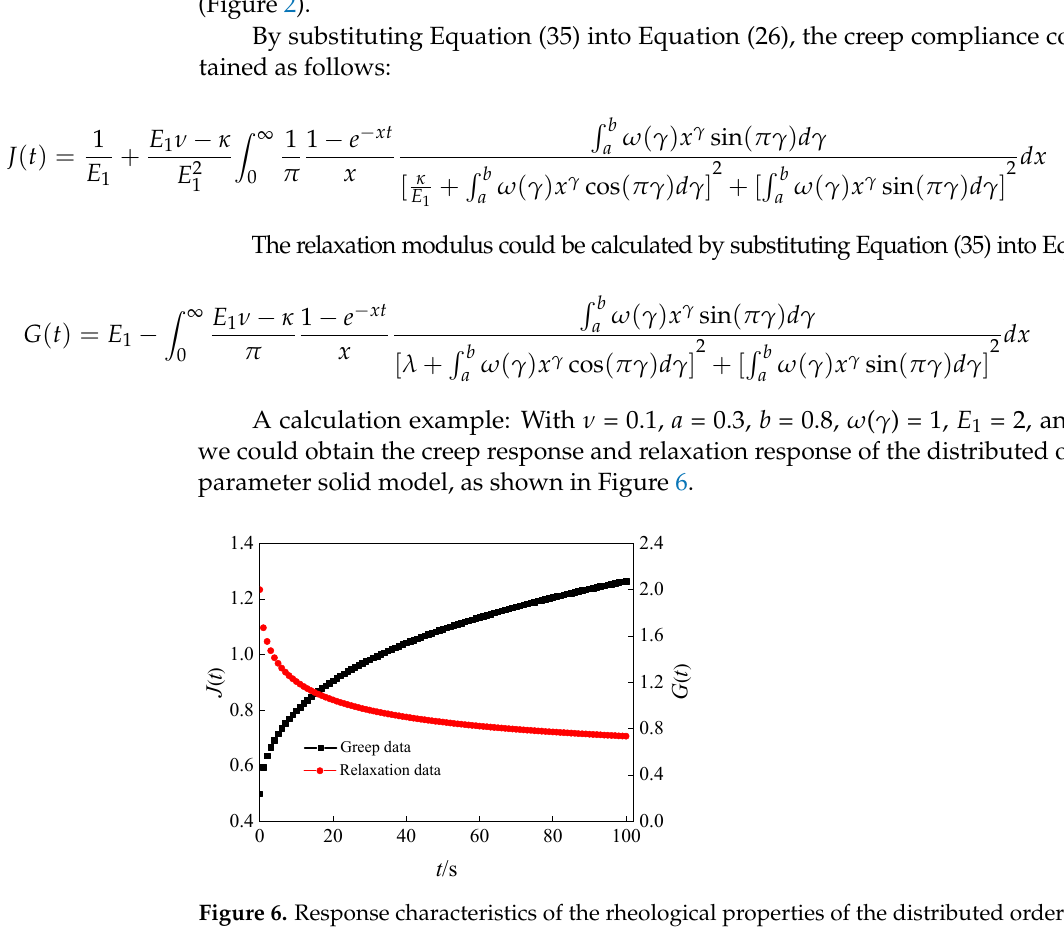
Figure 6. Response characteristics of the rheological properties of the distributed order rheological model.